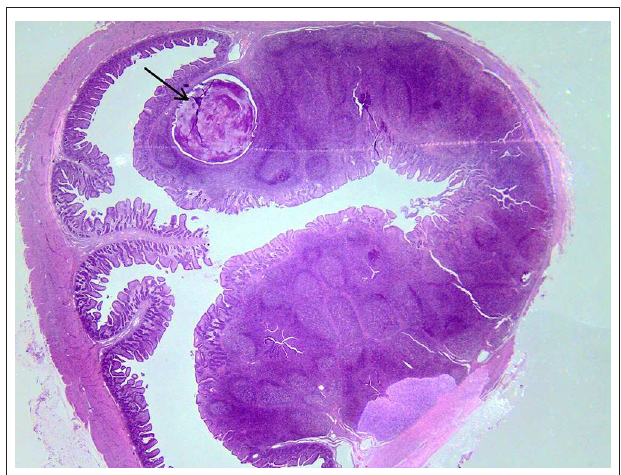
FIGURE 7 | Subluminal lesion (arrow) characterized by liquefactive necrosis of tissue in the PP of a pig fed with the FP